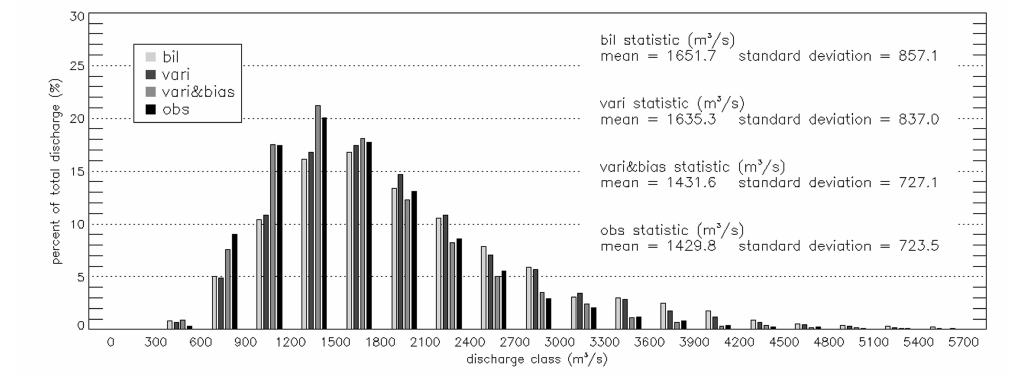
Fig. 7. Percentage of total discharge in different discharge ranges (class width=300m 3 s − 1 ) according to observations and the simulations of the cross-validation experiment (1972–2000).